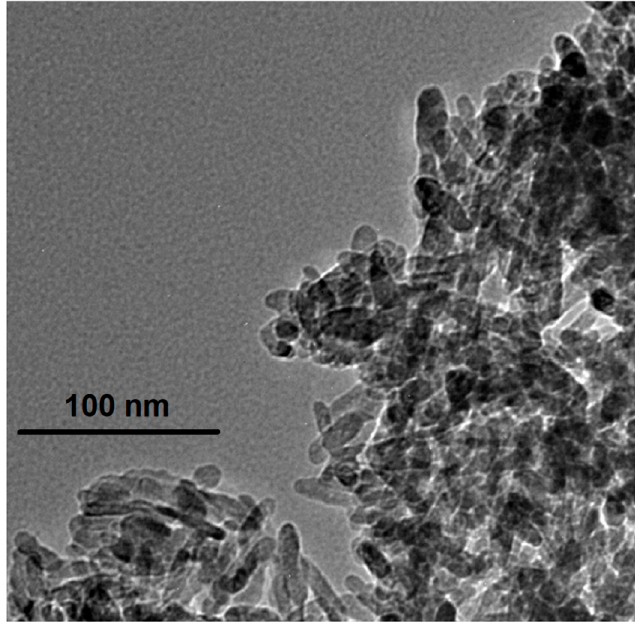
Table 1. Lattice constant and crystalline sizes calculated from the XRD patterns of the synthesized 10Ce-HAp suspension.